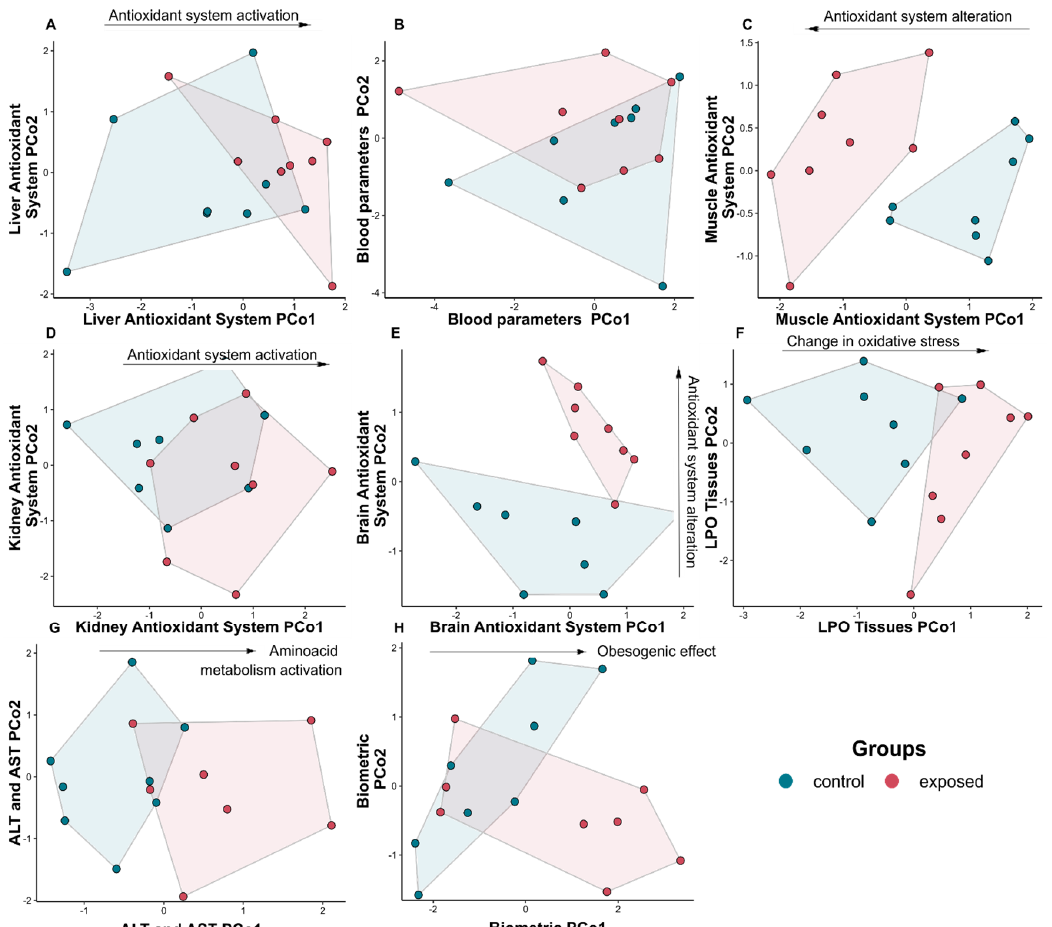
Figure 3. Principal coordinates analysis (PCoA) plot: ( A ) liver antioxidant system (SOD; GST; GPx and GR); ( B ) blood parameters (Hb, HT, RBC, WBC, SN, SEN, LY, MY, EP, BP, MCV, MCH and MCHC); ( C ) muscle antioxidant system; ( D ) kidney antioxidant system (SOD; GST; GPx and GR); ( E ) brain antioxidant system (SOD; GST; GPx and GR); ( F ) oxidative stress (LPO liver; LPO muscle; LPO kidney; LPO brain); ( G ) aminoacid metabolism (ALT and AST); ( H ) biometrics parameters (WG, WGR, TC, FE, WGCI).